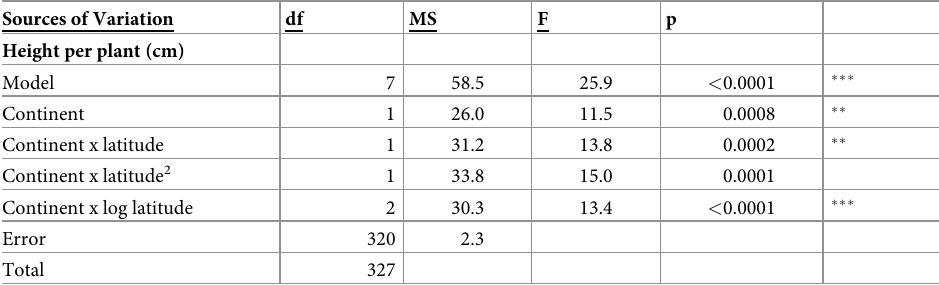
Error Total 327 Only significant main effects and interactions are reported in this Generalized Linear Model approach. Significance is indicated by ‘ ��� ’ and ’ �� ’ (p � 0.001, p � 0.01,